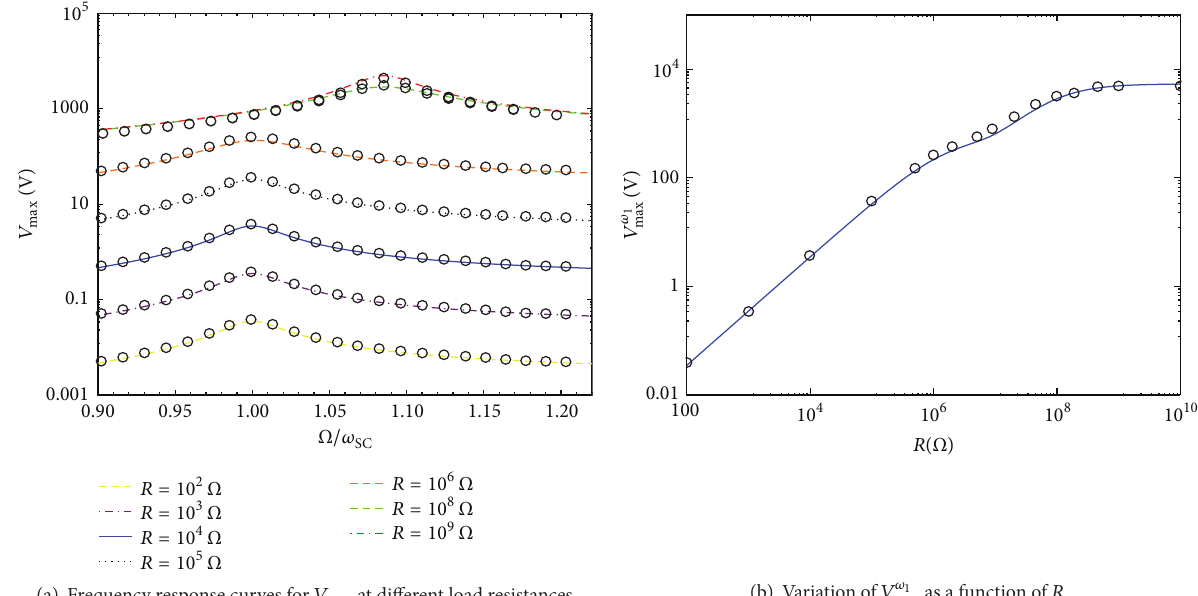
Figure 7: Analytical and FE harvested voltage at different excitation frequencies and load resistances: analytical prediction (continuous and dashed lines) and FE model (circles).